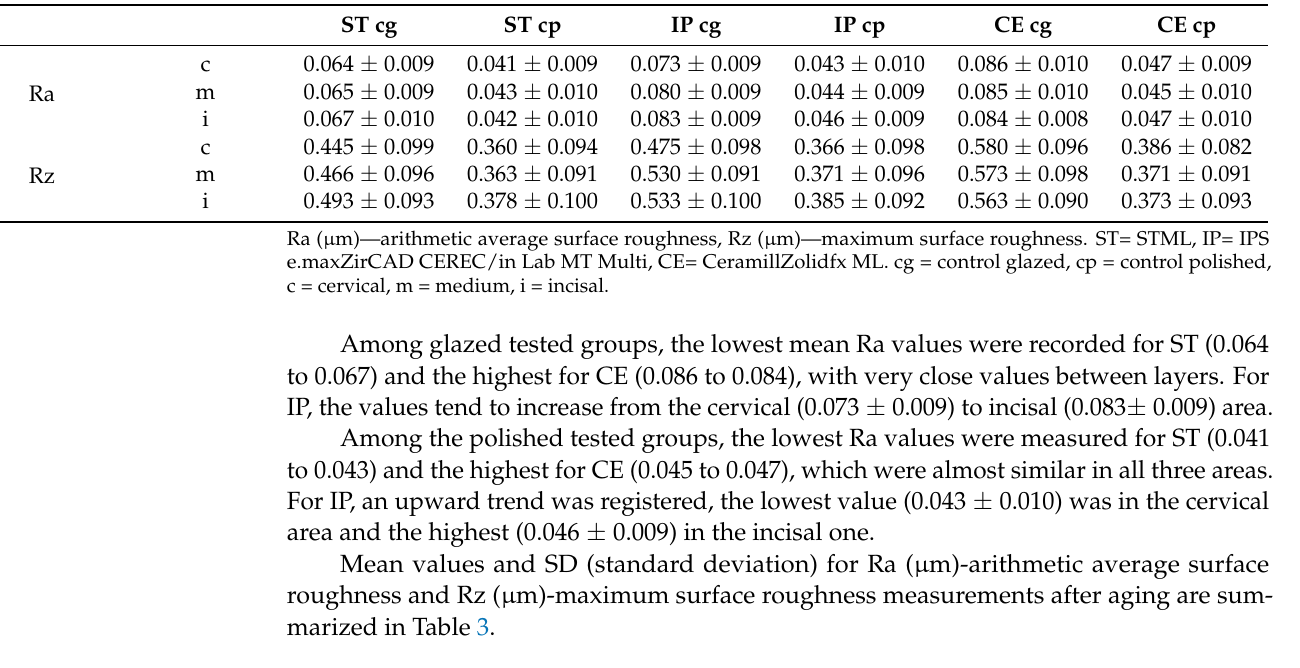
Table 3. Mean values with SD for Ra, Rz parameters of the samples, after aging (n = 8). ST ag ST ap IP ag IP